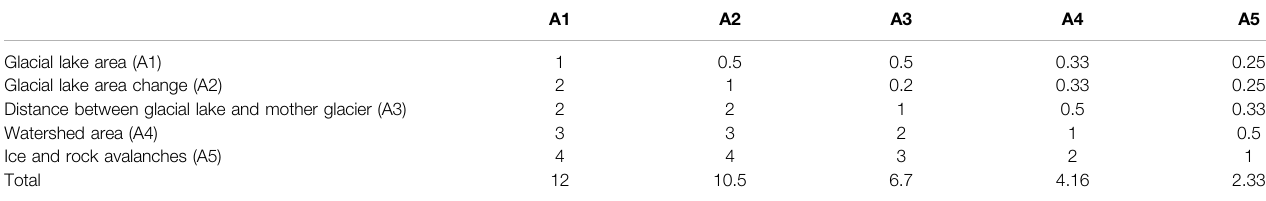
TABLE 3 | Pairwise comparison of glacial lake outburst factors.